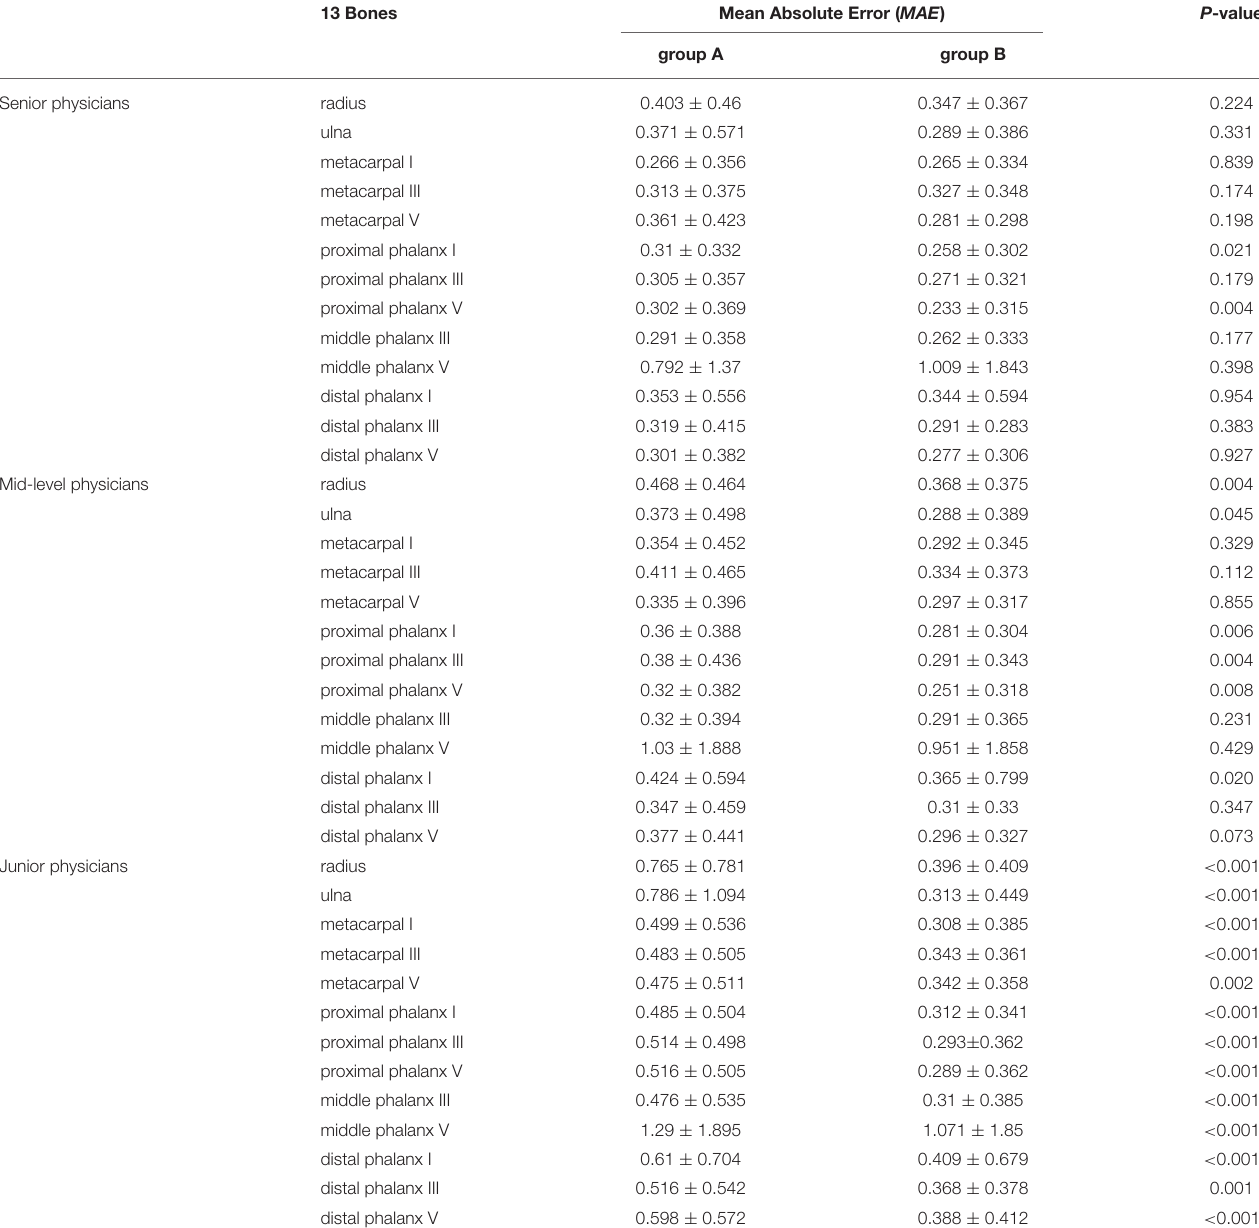
TABLE 3 | MAE for assessments of 13 bones (radius, ulna, and short